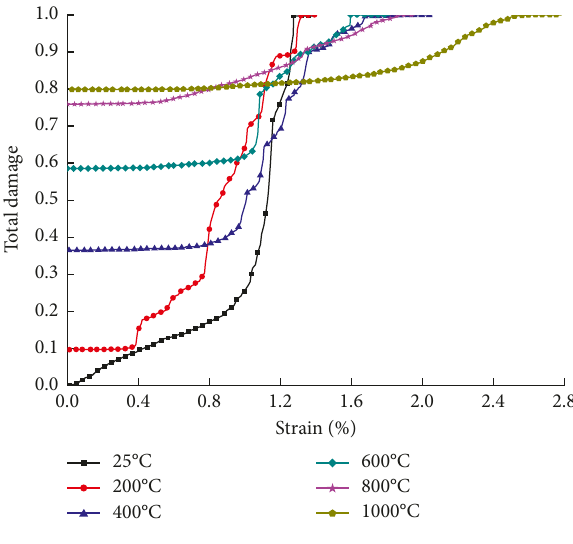
Figure 12: Total damage with strain.